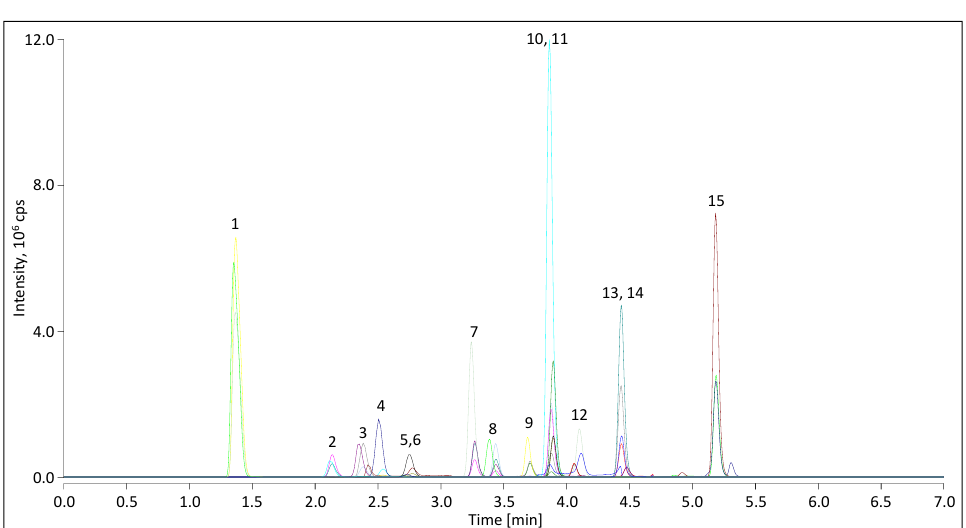
0 . 51 . 01 . 52 . 02 . 53 . 03 . 54 . 04 . 55 . 05 . 56 . 06 . 5 T i m e [ m i n ] Figure 1. Overlay chromatogram of all monitored ion transitions of a QC level II sample of 11-deoxycorticosterone (11-DOC), 11-deoxycortisol (11-DF), 17-OH-progesterone (17P), 21-deoxycortisol (21-DF), androstenedione (ANDRO), aldosterone (ALDO), corticosterone (CC), cortisol (CL), cortisone (CN), dehydroepiandrosterone (DHEA), dehydroepiandrosterone sulfate (DHEAS), dihydrotestosterone (DHT), estradiol (E2), progesterone (PROG), and testosterone (TES). Each transition was only monitored at the respective time window. All three transitions (QN, QL, IS) are depicted for every analyte. Each transition is depicted in an individual color. Peak labeling: 1. DHEAS; 2. CL; 3. CN; 4. 21-DF; 5., 6. E2 and ALDO; 7. 11-DF; 8. CC; 9. DHEA; 10., 11. TES and 17P; 12. DHT; 13., 14. ANDRO and 11-DOC; 15.